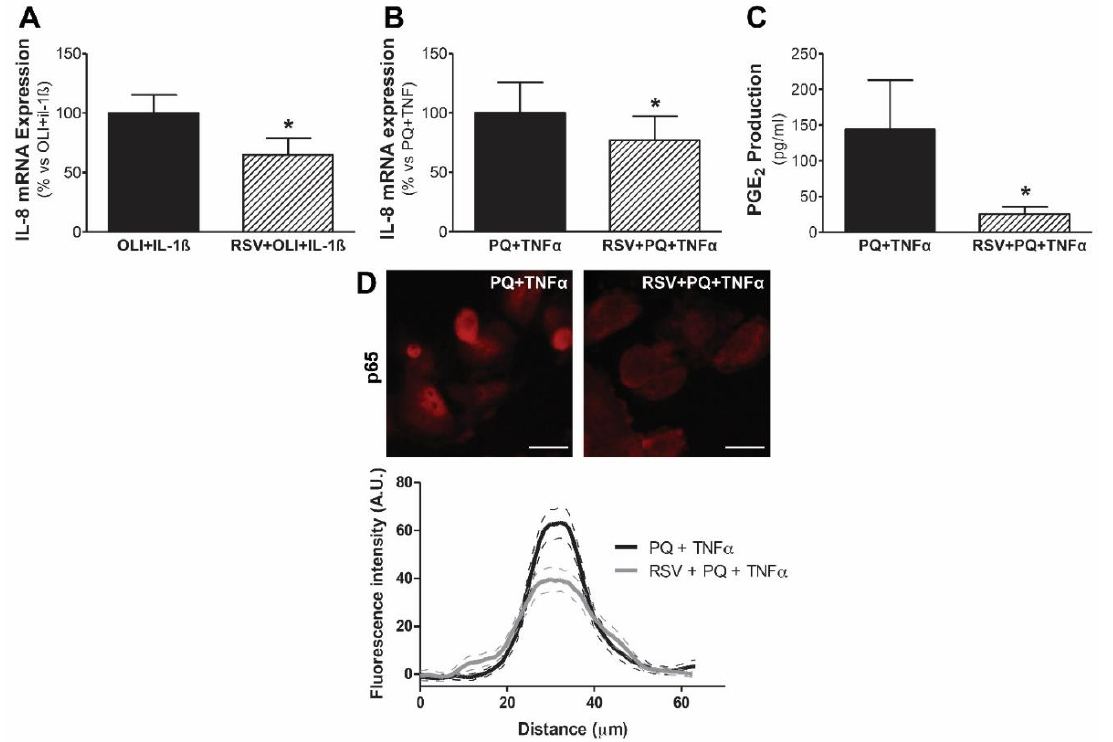
Figure 6. Modulatory effects of resveratrol on the inflammatory response induced by mitochondrial dysfunction plus cytokines. Met5A mesothelial cells were treated with or without resveratrol (RSV; 5 µM) for 30 min before stimulation with oligomycin (OLI; 10 µg/mL) or paraquat (PQ; 1 mM) for 30 min plus treatment with IL-1 β (1 ng/mL, 6 h) or TNF α (1 ng/mL, 18 h). IL-8 mRNA expression for ( A ) OLI + IL-1 β (n = 7) and ( B ) PQ + TNF α (n = 7). Data are expressed as the mean ± SEM fold change vs. control. ( C ) PGE2 production for PQ + TNF α (n = 10). Data are expressed as mean ± SEM pg/mL. ( D ) Representative immunofluorescence of p65 in Met5A mesothelial cells pretreated or not for 30 min with RSV before PQ + TNF α treatment for 40 min (n = 3). Scale bars, 25 µ m. Bottom panel shows the fluorescence intensity plot profile, measured in transects taken through individual cells (n = 30 for each condition). The data were expressed as mean ± SEM.* p ≤ 0.05 vs. control.